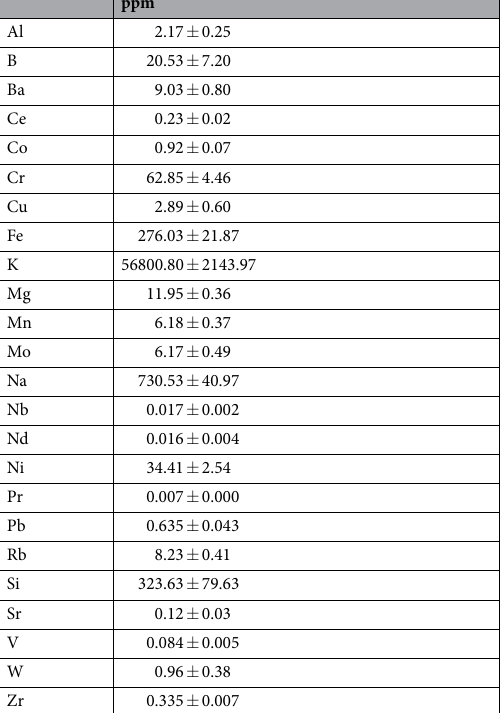
Table 1. Composition of GN determined by ICP-MS. The reported values are the averages of two independent sample analyses.